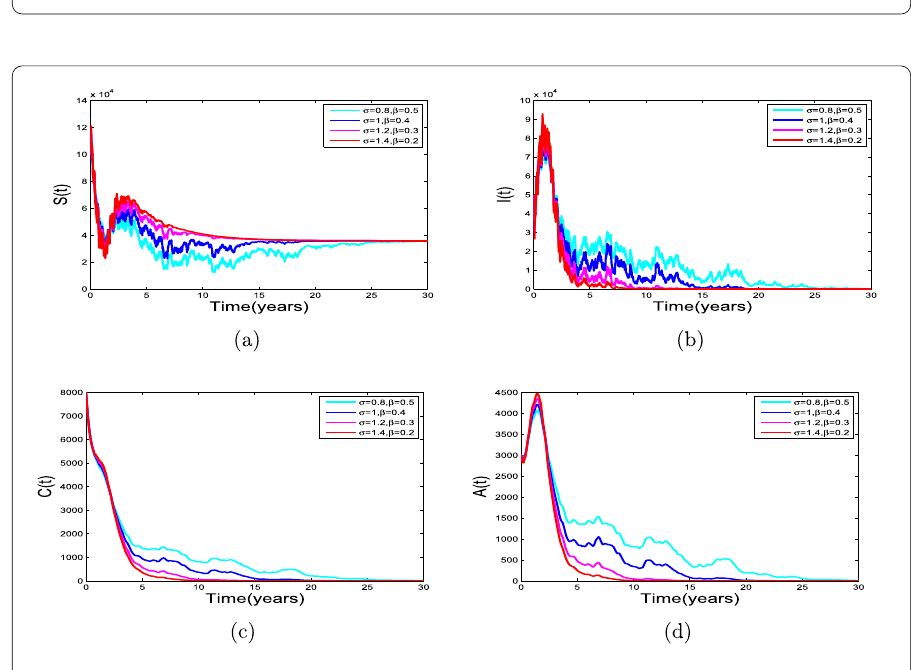
Figure 6 The path of ( S ( t ), I ( t ), C ( t ), A ( t )) for stochastic model (1.2) when σ = 0.8,1,1.2,1.4 and β = 0.5,0.4,0.3,0.2